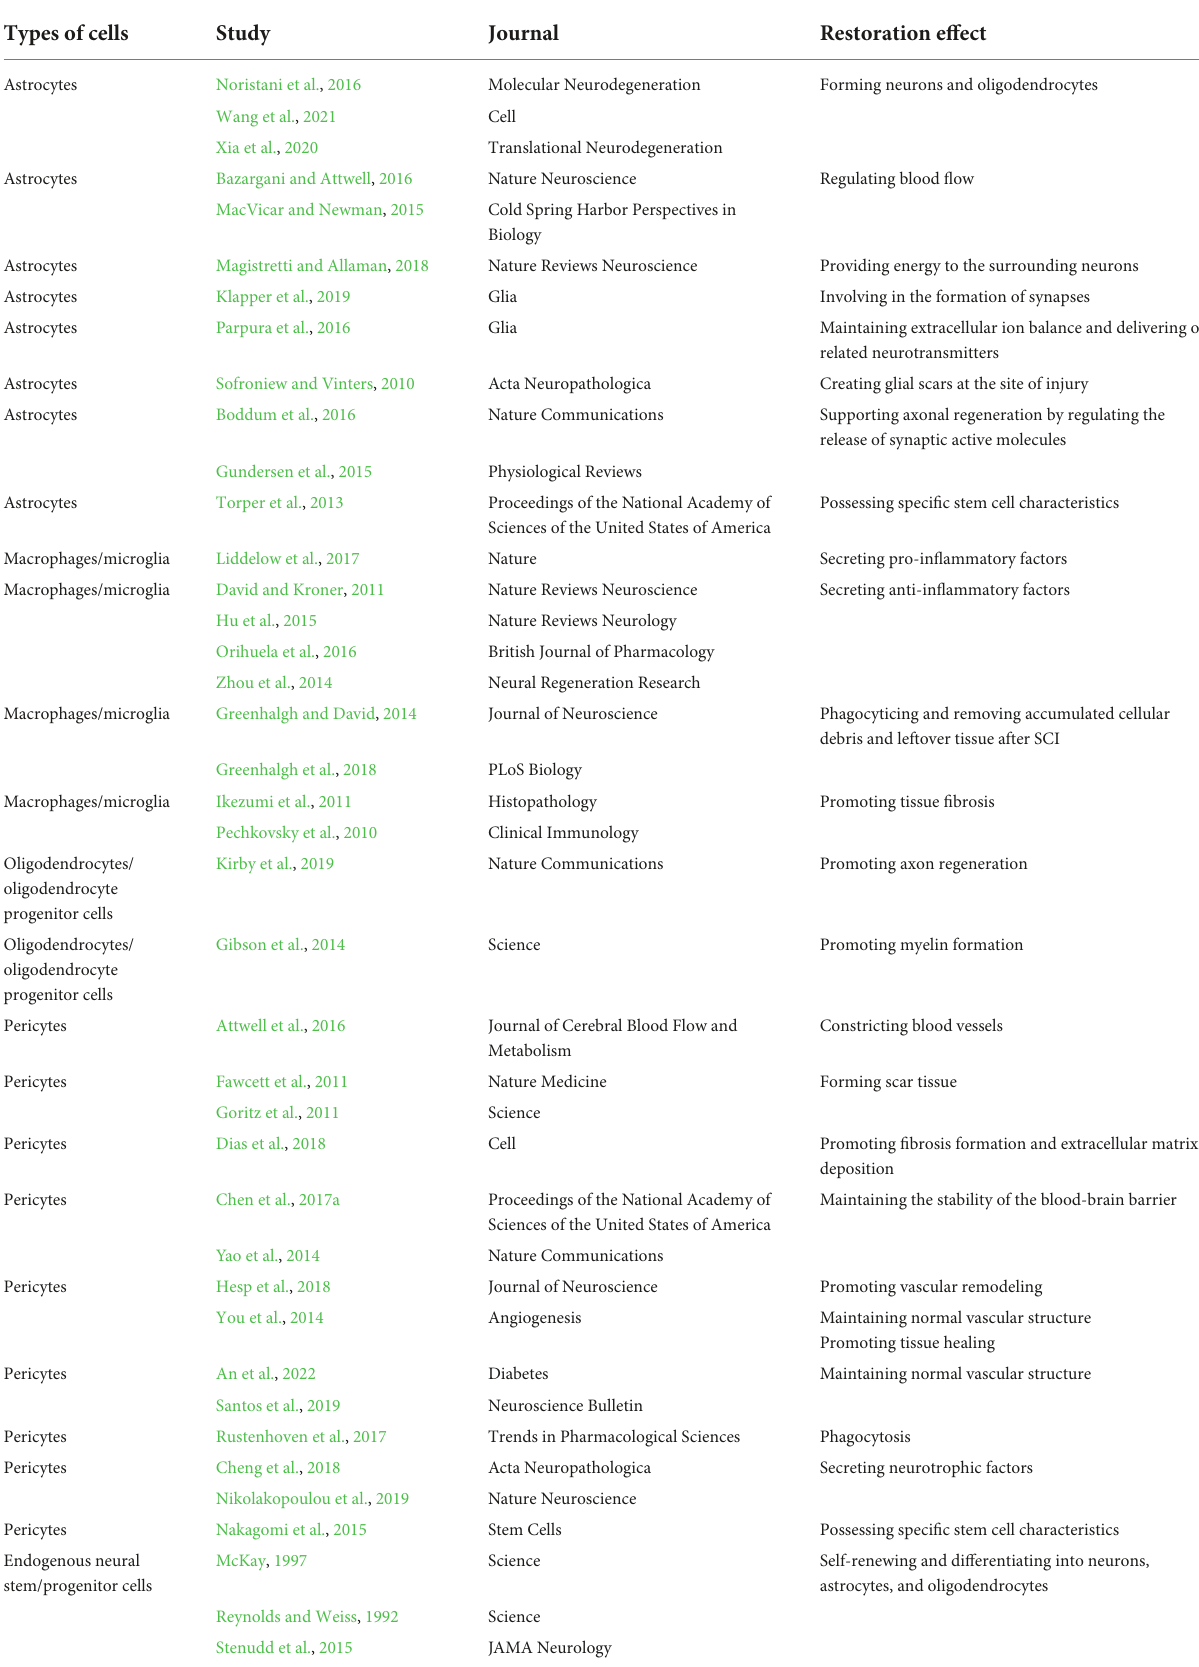
TABLE 1 Cells involved in the repair process of SCI and their repair